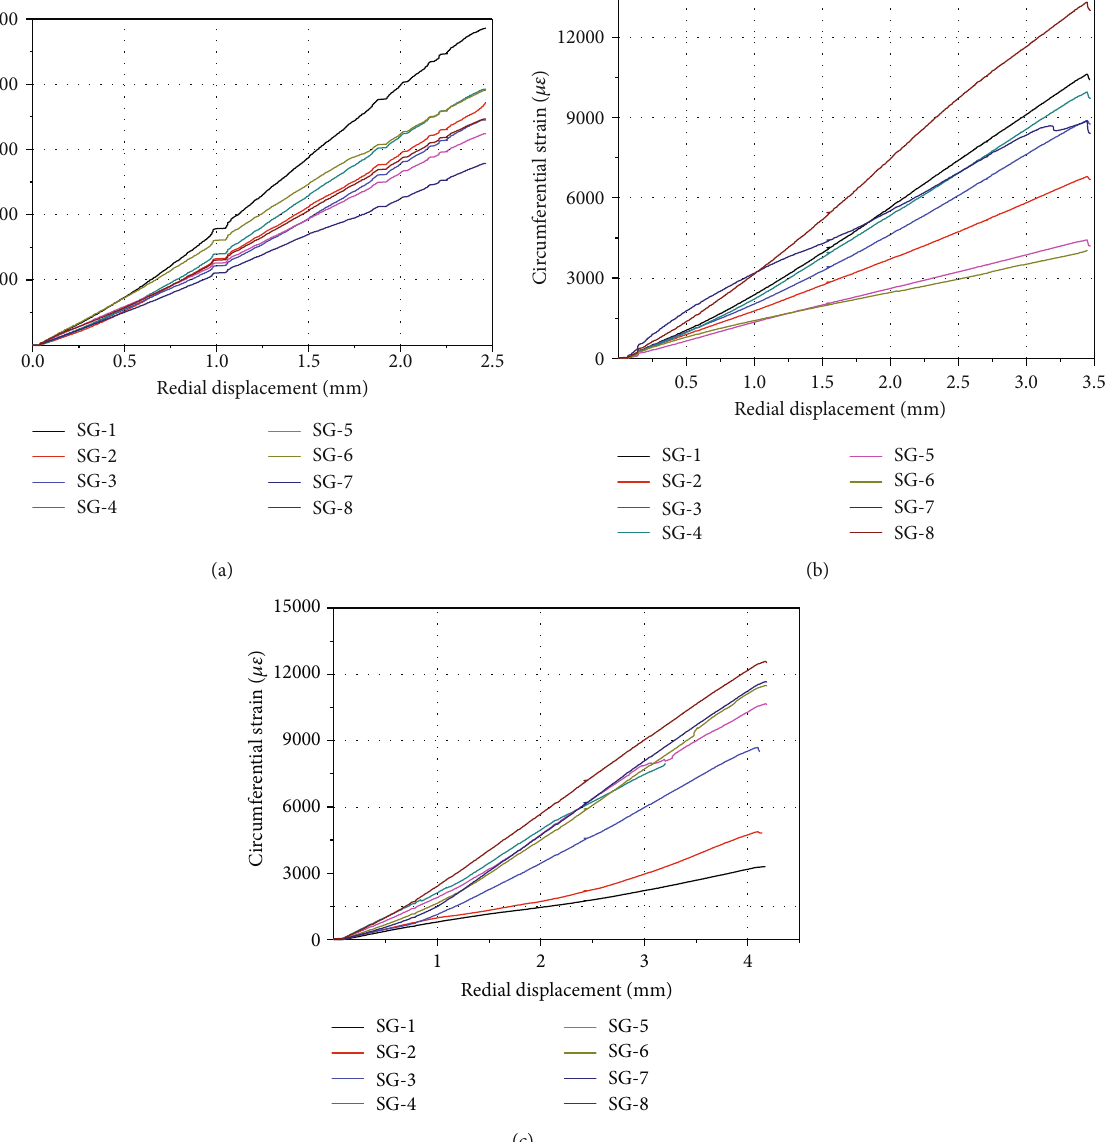
Figure 17: The circumferential strain-radial displacement curve of the test group with 2-layer prepreg wrap: (a) G-2-1 curve, (b) G-2-R-1 curve, and (c) G-2-2R-1